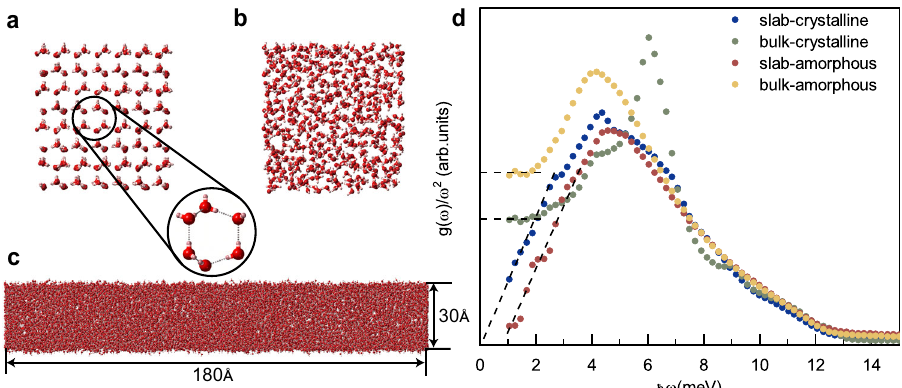
Fig. 4 The molecular dynamics (MD) simulations performed at 120 K. a The snapshot of the structure of the bulk ice sample. For visual purposes, only a few layers are kept. The zoom emphasizes its hexagonal structure. b The snapshot of the structure of the bulk amorphous ice sample. Also here, only a few layers are kept. c The amorphous ice slab sample with size 180 Å and con fi nement length along the z direction 30 Å . Here, the original structure is kept. d The normalized VDOS in function of frequency obtained from the MD simulations for slab ice (blue), bulk crystalline ice (green), slab amorphous (red) and bulk amorphous ice (yellow). The horizontal dashed lines indicate the Debye level for the bulk systems. The diagonal dashed lines guide the eyes towards the g ( ω ) ~ ω 3 low-frequency scaling. The y -axes are presented in arbitrary